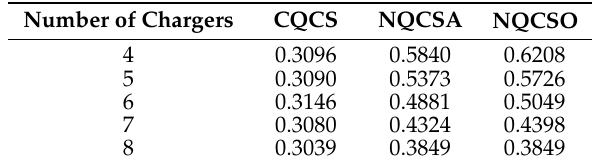
Table 5. Utilisation ratios of the CS with different number of chargers during the simulation period in different charging situations.